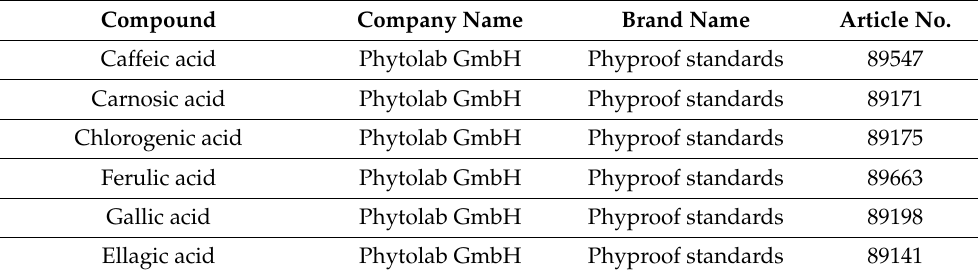
Table 7. References used for identification of compounds in the LC/MS